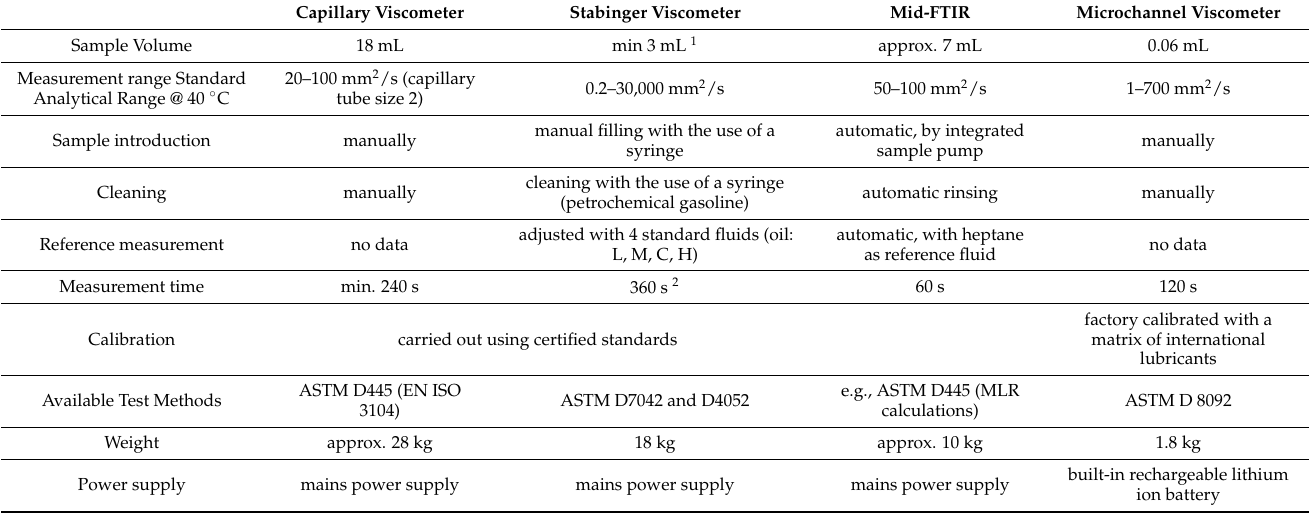
Table 1. Basic features of the devices used in the